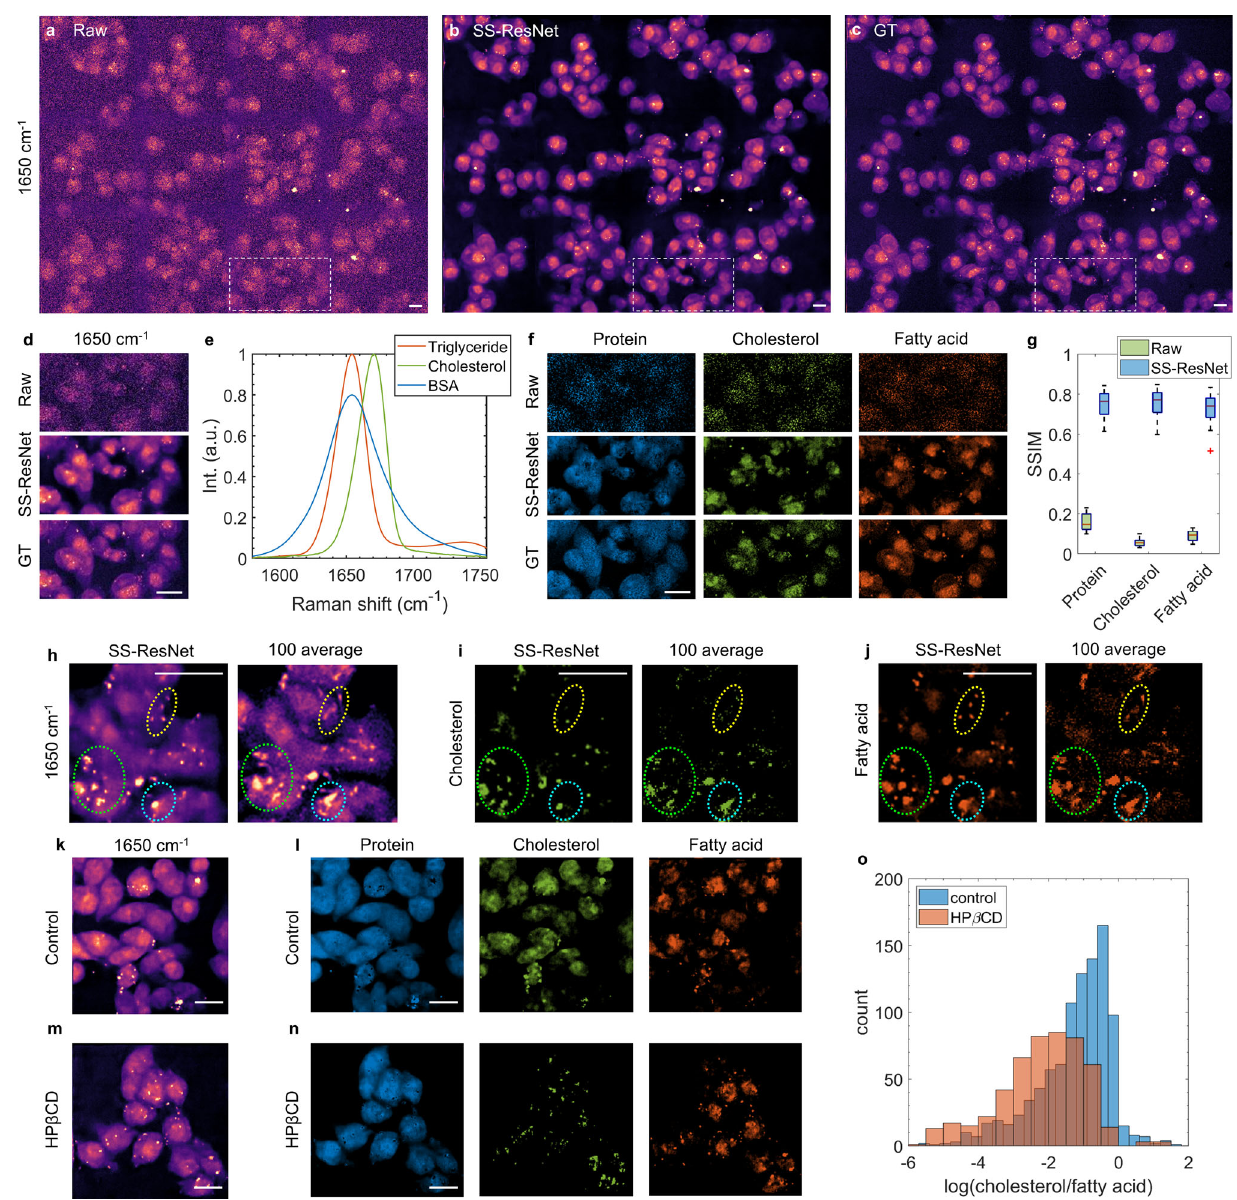
Fig. 2 High-speed spectroscopic fi ngerprint SRS imaging of living Mia PaCa-2 cells. a – c Fingerprint spectroscopic SRS imaging of fi xed Mia PaCa-2 cells by single raw acquisition, spatial-spectral residual net (SS-ResNet) recovery from raw data, and 100 images averaging ground truth (GT). d Zoom-in comparison of the same region of interest shown in white dashed boxes in ( a – c ). e Fingerprint SRS spectra of bovine serum albumin (BSA), cholesterol, and triglyceride serving as the pure spectral references of protein, cholesterol, and unsaturated fatty acid. Int., intensity. a.u., arbitrary unit. f Chemical maps of protein, cholesterol, and fatty acid by pixel-wise LASSO unmixing from spectroscopic SRS images shown in ( d ). g Quantitative analysis of chemical mapping accuracy after network recovery. Box plots ( n = 19) show the SSIM for raw vs. GT and network vs. GT of the three chemical channels. The boxes show interquartile range (IQR), the red line indicates medians, the black lines represent whiskers which extend to 1.5 times of the IQR and the red data points are the outliers exceeding the whiskers. SSIM, structural similarity index. h Fingerprint spectroscopic SRS imaging of living Mia PaCa-2 cells by SS- ResNet recovery of single raw acquisition and 100 averaging. i , j Cholesterol and fatty acid maps by LASSO unmixing from data in ( h ). Three signi fi cant motion artifacts are highlighted as circled regions. k , l High-speed imaging of living Mia PaCa-2 cells in normal conditions after network recovery, followed by chemical maps of protein, cholesterol, and fatty acid. m , n High-speed imaging of living Mia PaCa-2 cells with HP β CD treatment after network recovery, followed by chemical maps of protein, cholesterol, and fatty acid. o Single-cell statistical analysis of the ratio between cholesterol and fatty acid over ~1000 cells in control and HP β CD-treated group. Scale bars, 20 µ